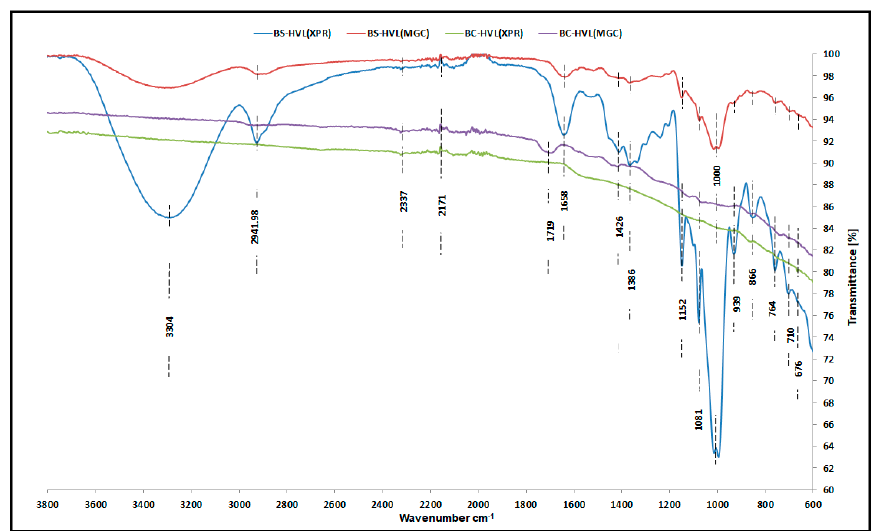
Figure 10. FTIR spectra of BS − HVL (X − PR), BS − HVL (MGC), BC − HVL (X − PR) and BC − HVL (MGC) after adsorption showing the appearance of the new functional groups in the BC-HVL.